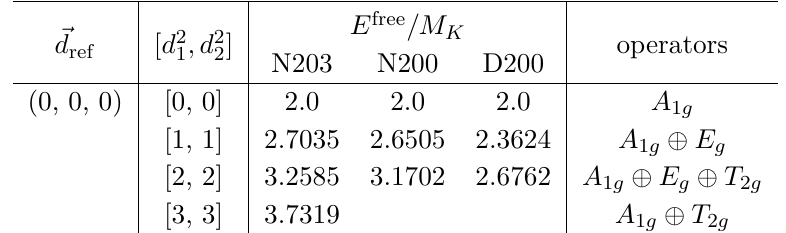
Table 29. Same as table 21 except for the two-kaon operators with ~d 2